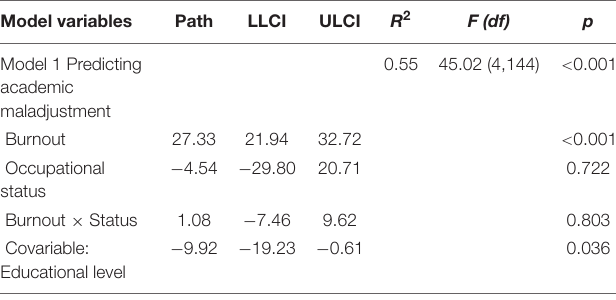
TABLE 3 | Path estimates and explained variance from the moderation